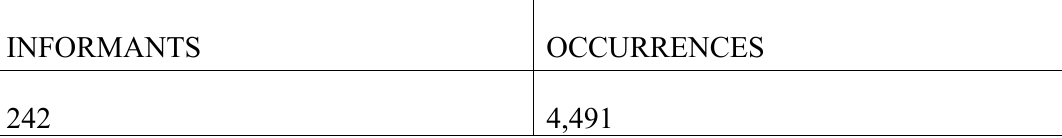
Table 2: Number of informants and